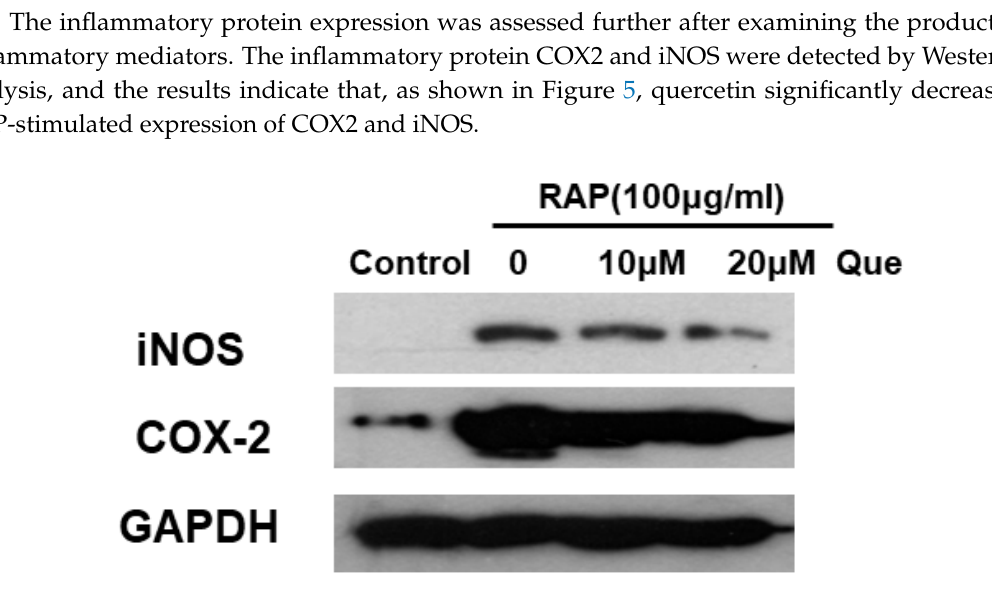
Figure 5. Effects of quercetin on RAP-induced COX2 and iNOS expression in RAW264.7 macrophages. RAW264.7 cells were treated with quercetin (10, 20 μ M) for 2 h and then treated with RAP (100 μ g/mL) for 24 h.